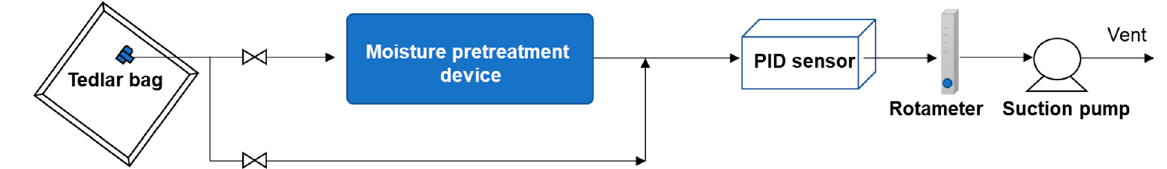
Figure 3. Experimental set-up for the VOCs recovery rate using a PID sensor.